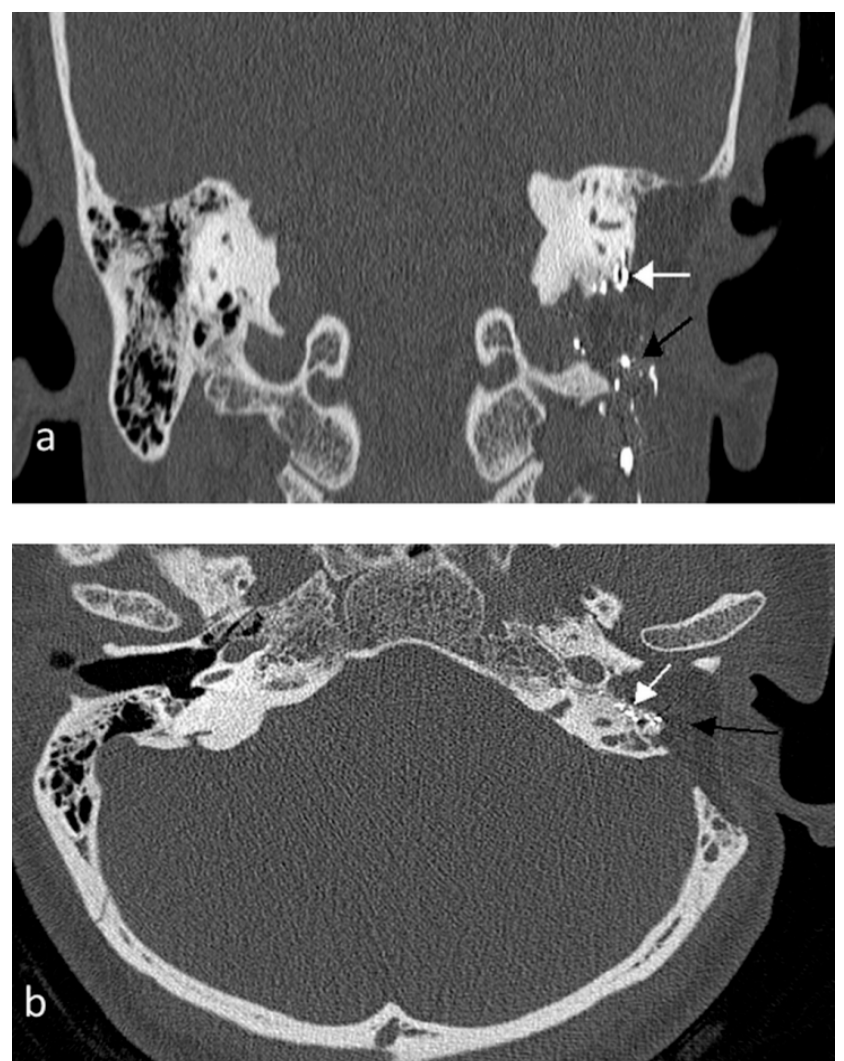
Figure 3. Post-operative computed tomography scan of temporal bone. ( a ) Coronal view shows hyper intense embolic material in the infralabrynthine (white arrow) and stylomastoid regions (black arrow). ( b ) Axial view shows middle ear and mastoid cavities filled with abdominal fat (black arrow); hyper intense embolic foci in the region of mastoid segment of the facial nerve (white arrow).